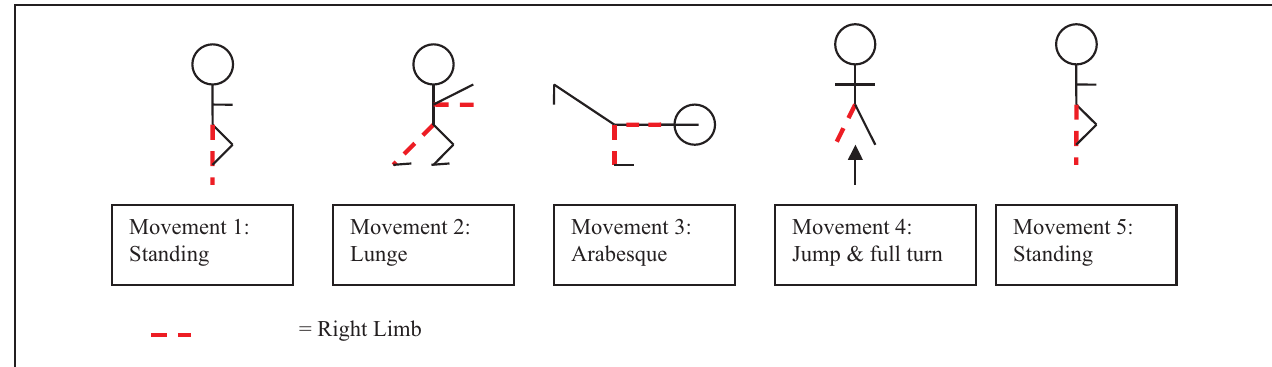
FIGURE 1 | Schematic representation of the five separate gymnastic movements contained within the gymnastics floor routine.